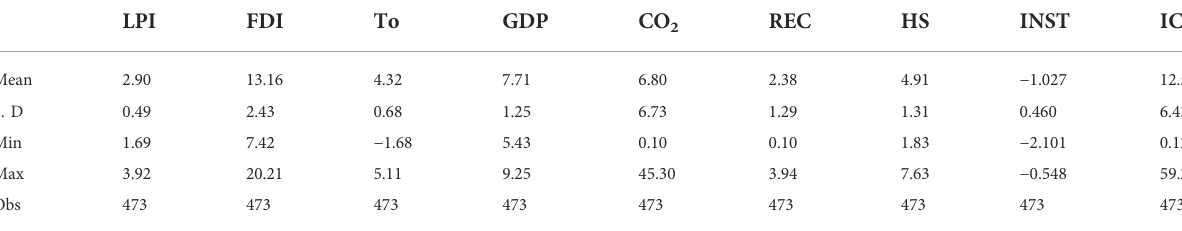
TABLE 3 Descriptive Statistics for a panel of states from the SSA countries.